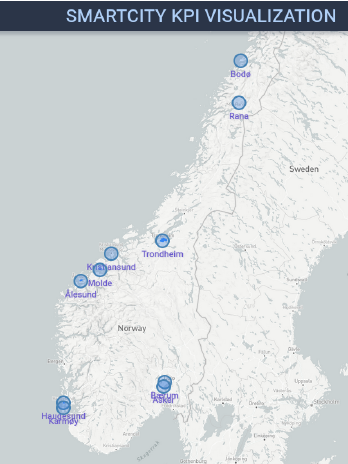
Figure 7. Comparison between ˚Alesund and Trondheim.